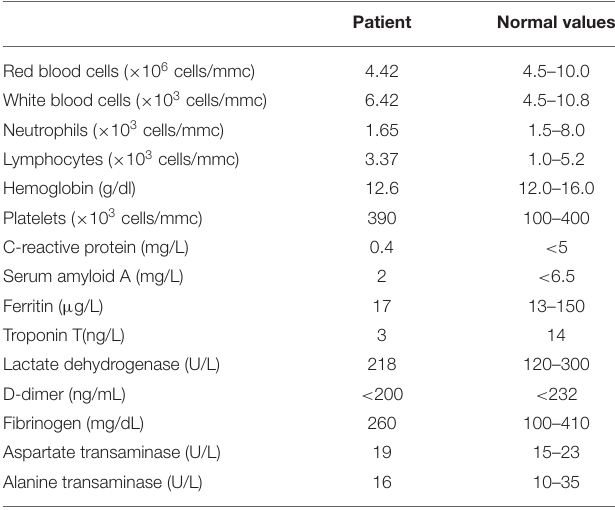
TABLE 1 | Acute-phase reactants and serum biochemistry values of the index patient.